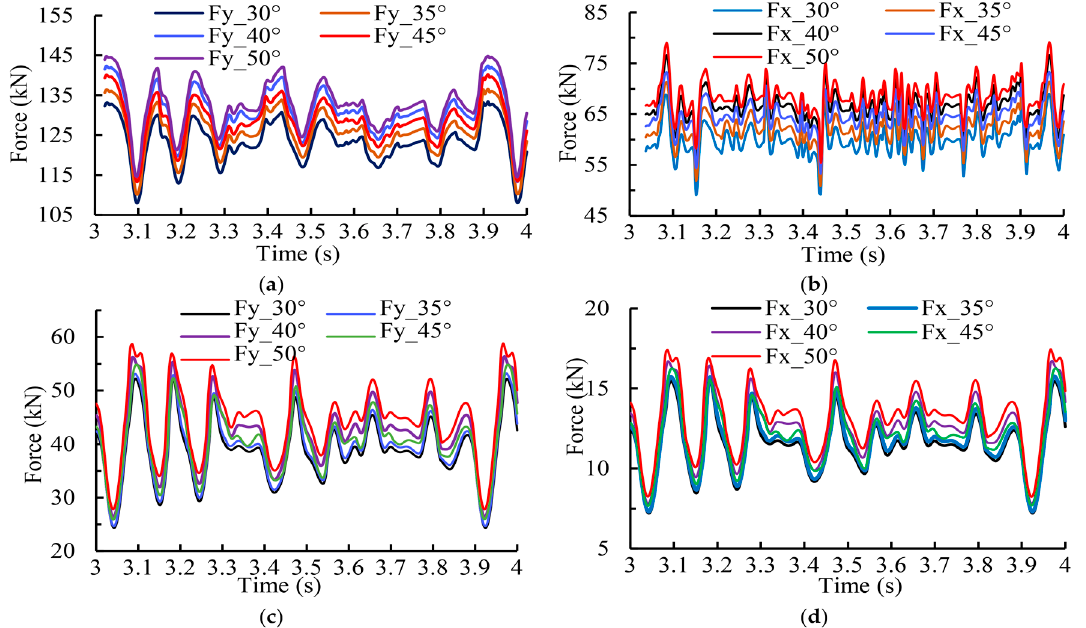
Figure 8. Mechanical property of the traction unit under different cutting arm angle: ( a ) The y-direction force of the walking wheel; ( b ) The x-direction force of the walking wheel; ( c ) The y-direction force of the support slipper; and ( d ) The x-direction force of the support slipper.